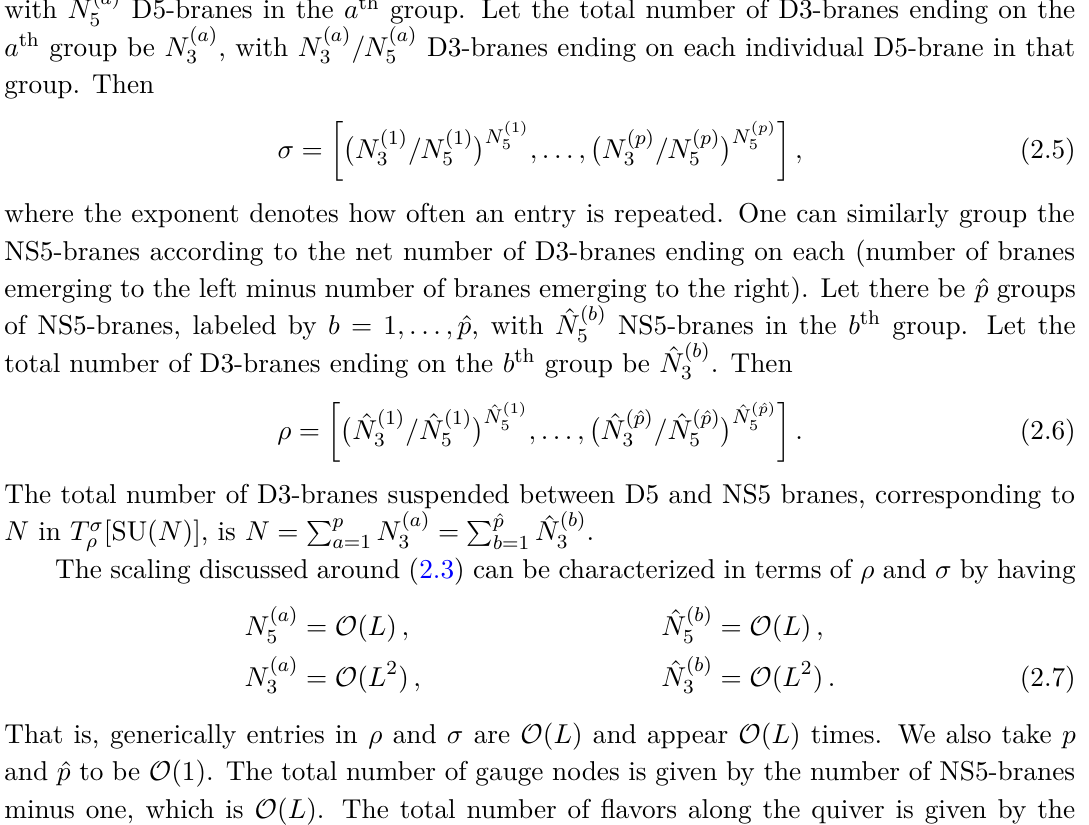
Figure 2 . Moving all D5-branes to one side, for the quiver [2] has as many D3-branes attached as it has crossed NS5-branes. The partitions are ρ = [4 , 2 , 2] , σ = [2 , 2 , 2 , 1 , 1] . The vertical positions of the D3-brane parametrize the Coulomb branch and do not affect the IR